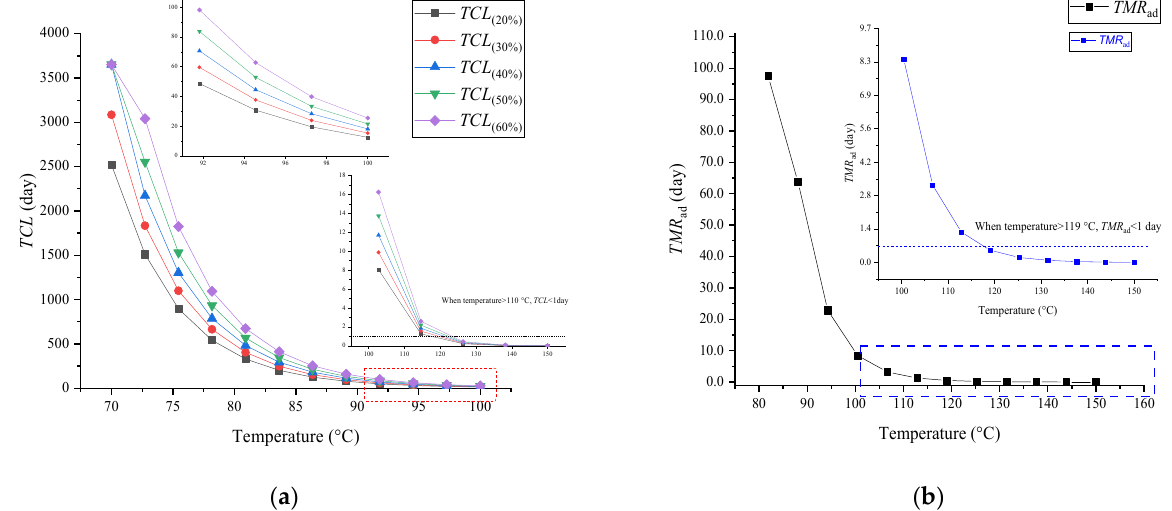
Figure 6. Simulation results of AIBA for ( a ) TCL and ( b ) TMR ad under different ambient temperatures from heating rate of 4.0 °C/min.